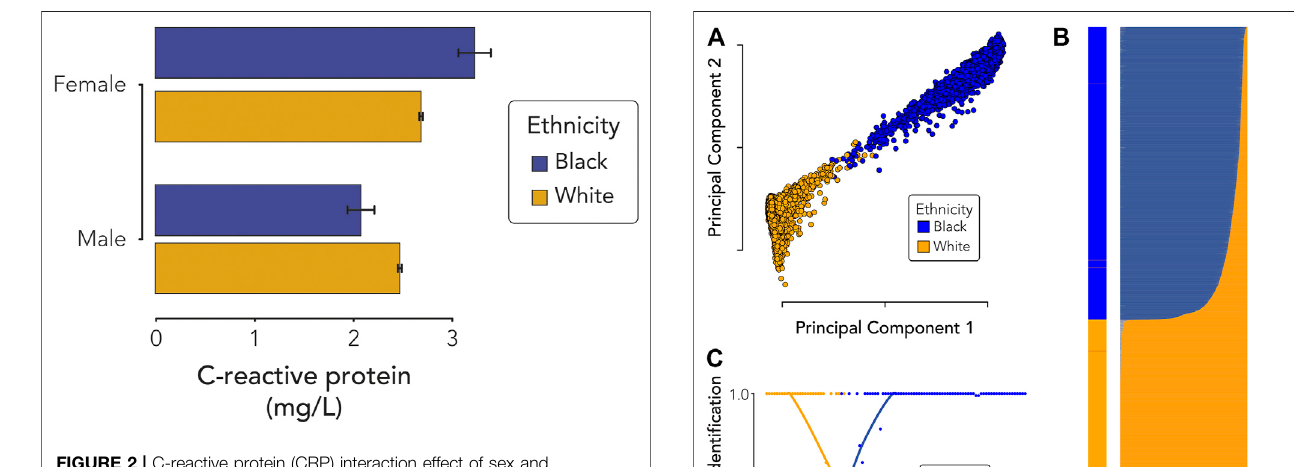
FIGURE 2 | C-reactive protein (CRP) interaction effect of sex and ethnicity.AverageCRPserumlevels( ± 95%CI)areshownforBlackandWhite, female, and male participants.